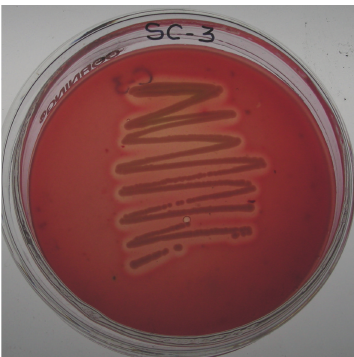
Figure 2: β Hemolytic activity shown by Aeromonas hydrophila strain An4. On blood